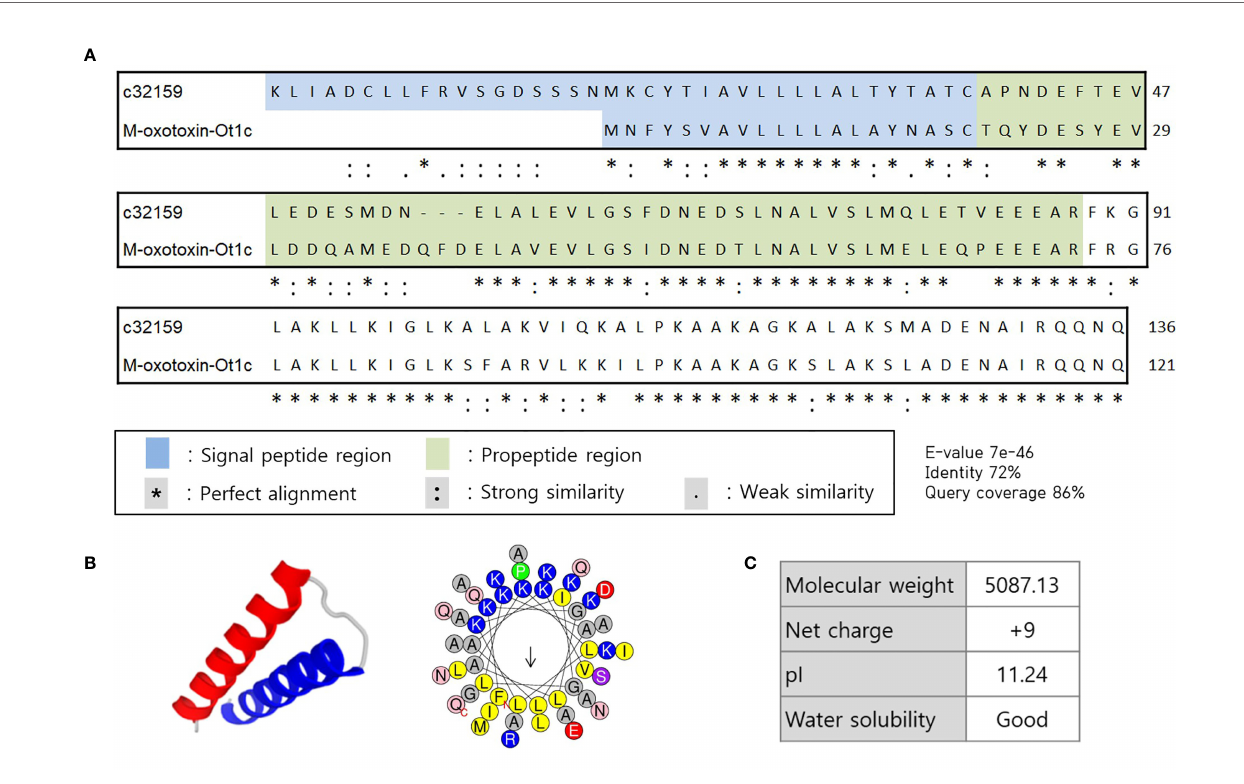
FIGURE 1 | Sequence alignment and structural representation of c32159. (A) High homology was revealed by BLAST on signal peptide region, propeptide region, and mature peptide of c32159 transcript. “ * ” , “ : ” , “ . ” indicates perfect alignment, strong similarity, and weak similarity, respectively. (B) In silico analysis predicted mature sequence of c32159 to have helix-loop-helix structure with distinct hydrophilic and hydrophobic faces. (C) Physiological properties were calculated of the